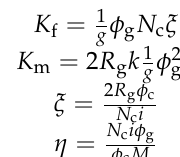
( b ) ( c ) Figure 13. The magnetic field cloud diagram of NLFM. ( a ) x = 0 mm, 𝑖 = −2 A. ( b ) x = 0 mm, 𝑖 = 0 A. ( c ) x = 0 mm, 𝑖 = 2 A.